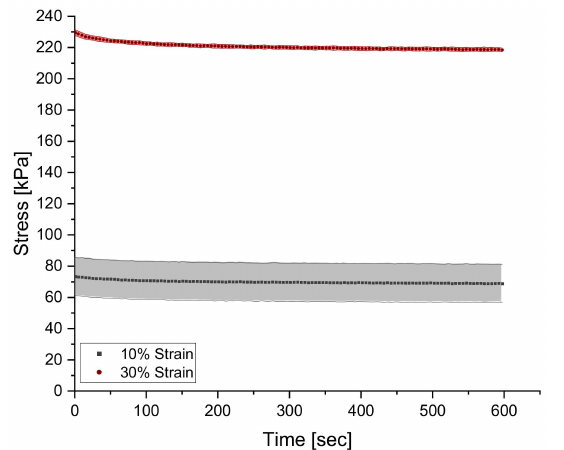
Figure 3. A comparison between a 10% and 30% strain test showcasing the low signal-to-noise ratio for the lower strain-level